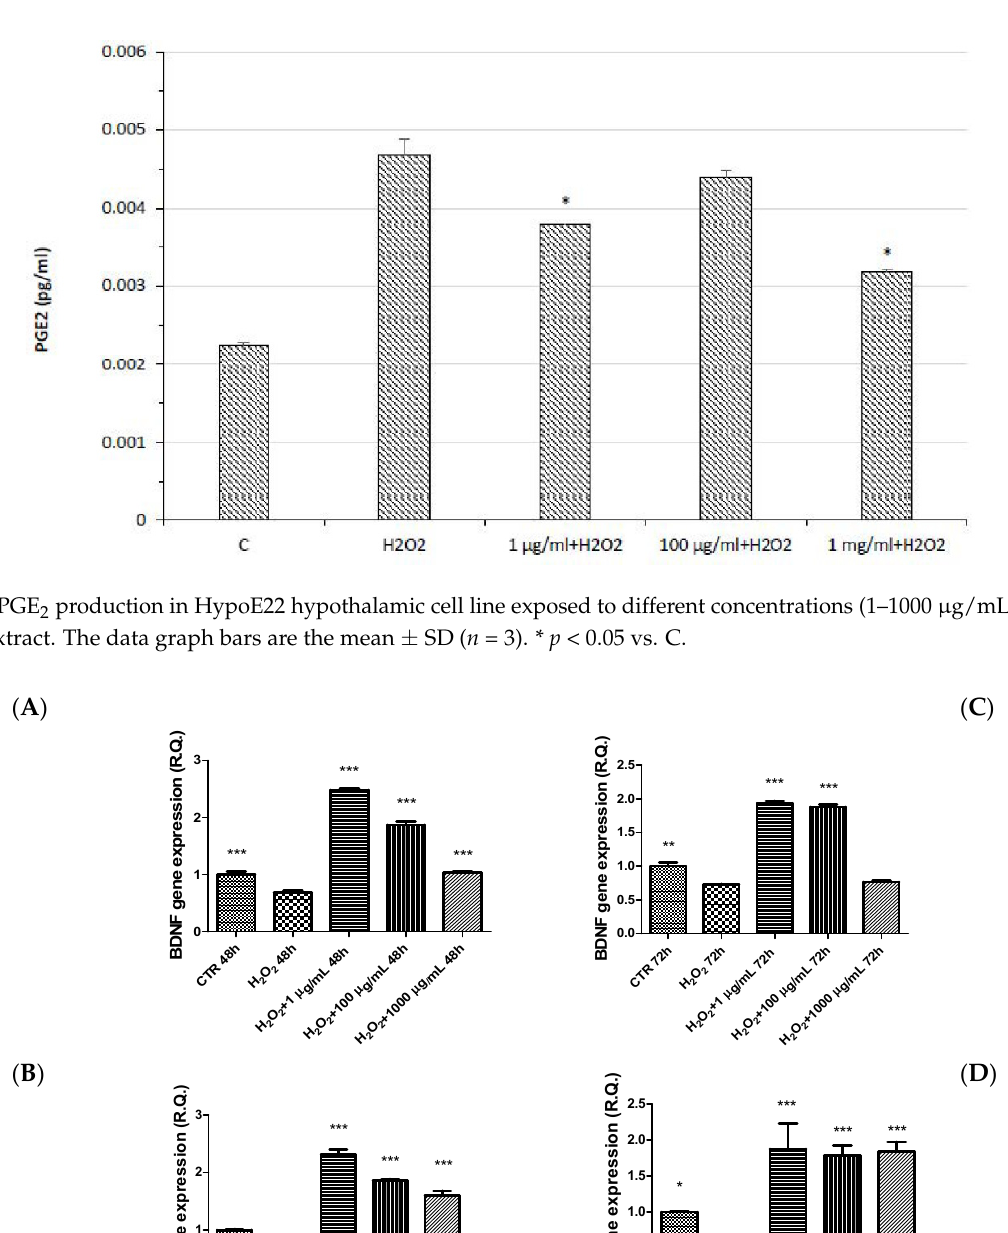
Figure 5. Inhibitory effects exerted by grape pomace water extract (1–1000 µg/mL) and catechin (5–500 ng/mL) on hydrogen peroxide (H 2 O 2 )-induced increase in cyclooxygenase-2 (COX-2) gene expression in HypoE22 cells. The efficacy of the extract was evaluated at different time points: 48 h ( A , B ); 72 h ( C , D ). ANOVA, p < 0.0001; * p < 0.05, *** p < 0.001 vs. respective hydrogen peroxide group (H 2 O 2 ).